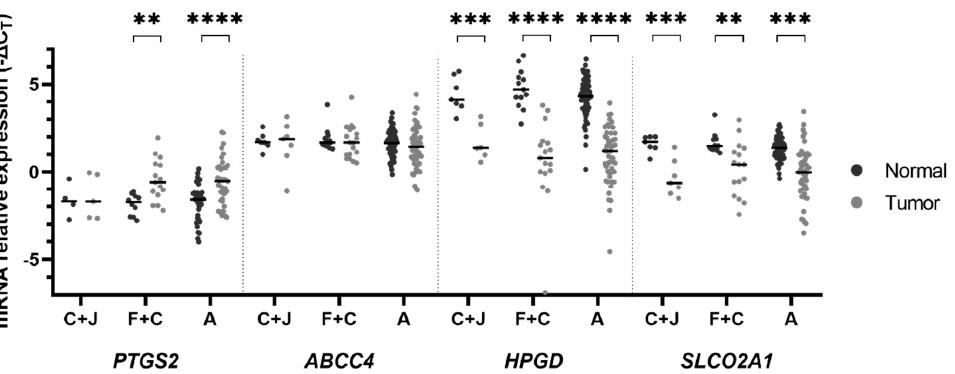
Figure 2. mRNA expression according to localization. PTGS2 is upregulated in tumor samples by a mean factor of 2.68 and 2.40 in F + C and A, respectively. HPGD and SLCO2A1 genes are downregulated in tumor samples compared to “normal”-appearing mucosa samples by a mean factor of 0.15 and 0.28, 0.14, and 0.36, 0.10, and 0.36 in C + J, F + C, and A, respectively. Lines represent median values of expression. ** p < 0.01; *** p < 0.001; **** p < 0.0001. C + J: Cardia and gastroesophageal junction; F +